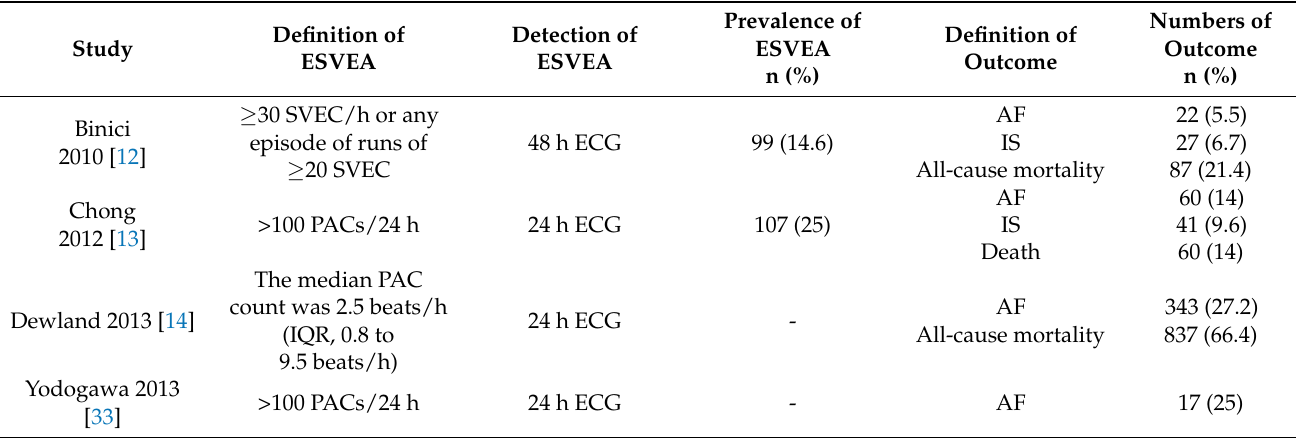
Table 2. Characteristics of ESVEA definition, ESVEA prevalence, and